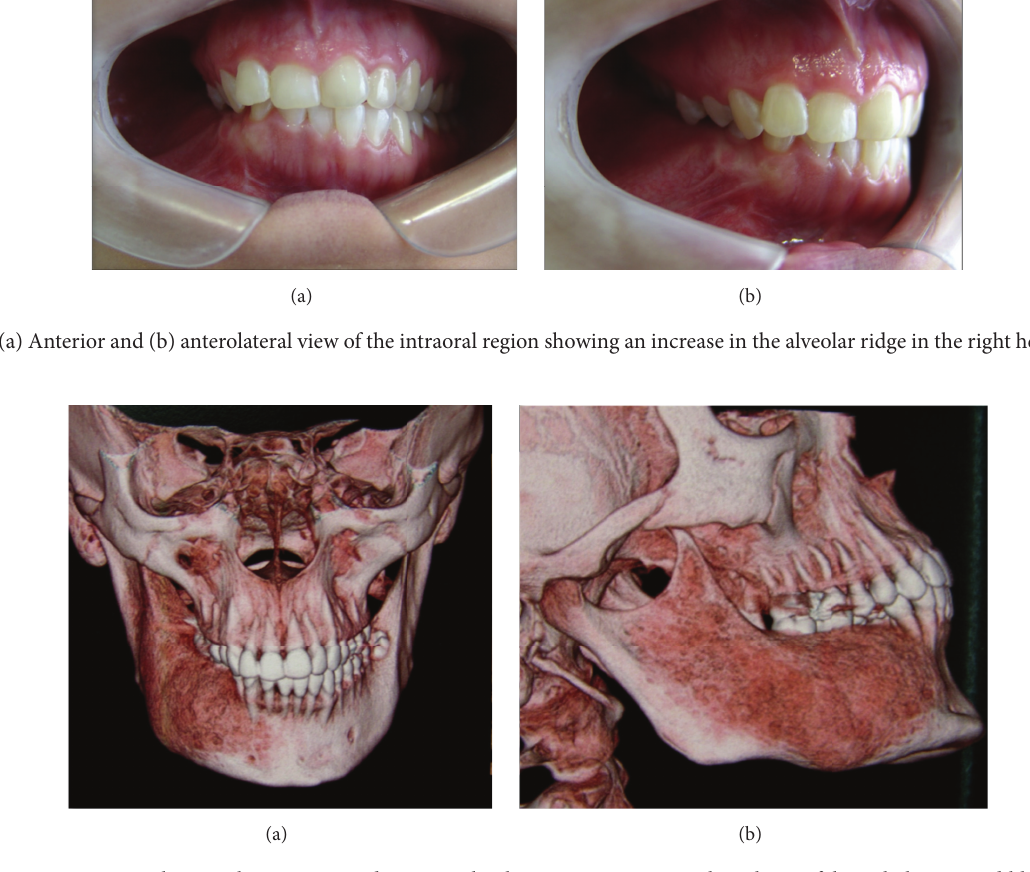
Figure 7: 3D reconstruction by cone-beam computed tomography showing an increase in the volume of the right hemimandible. (a) Anterior view and (b) lateral